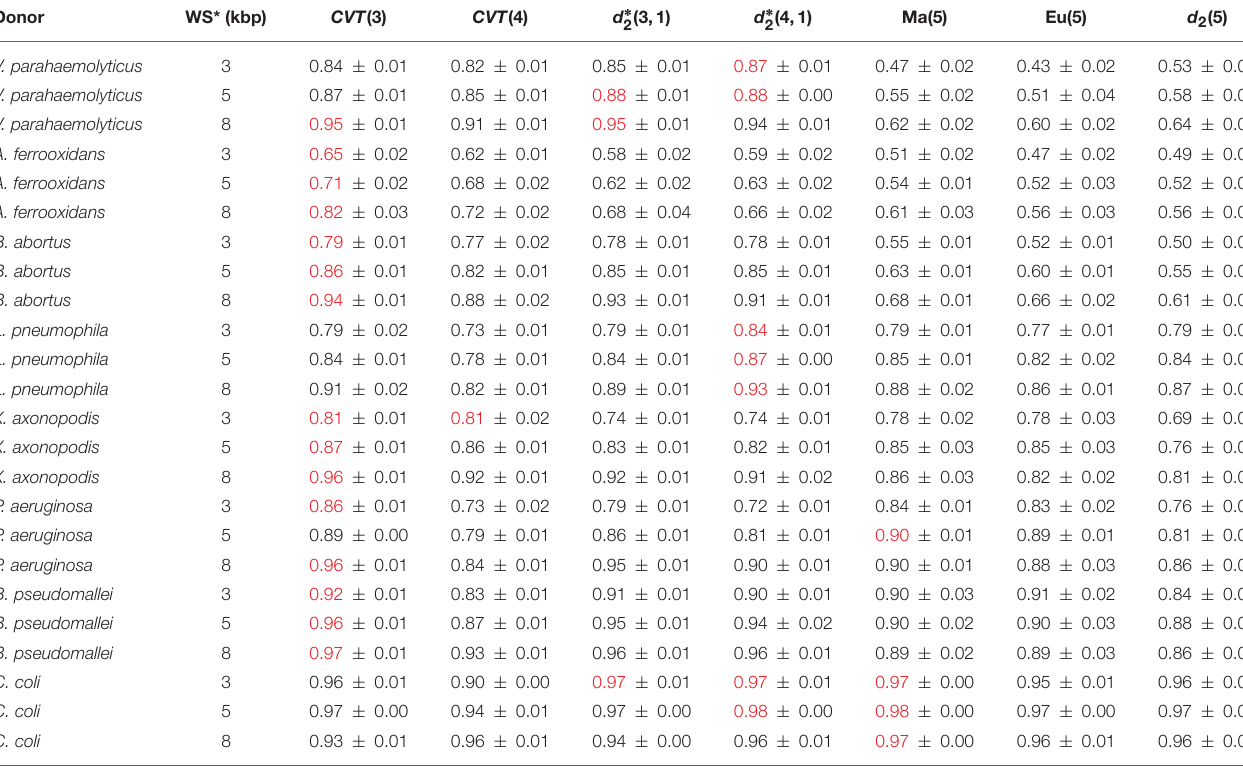
TABLE 3 | Performance of different methods over artificial genomes by using different window sizes. Donor